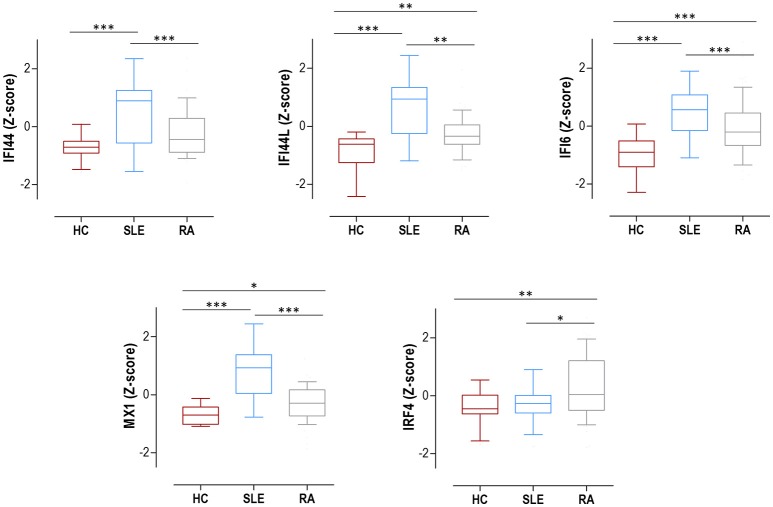
Expression of IRF4 and IRGs in SLE, RA patients and HC. IRF4 and IRGs (IFI44, IFI44L, IFI6, and MX1) gene expression in HC (dark red boxes) (n = 28), SLE patients (blue boxes) (n = 75), and RA patients (gray boxes) (n = 98). Results are shown as box plots, where the boxes represent the 25th and 75th percentiles, the lines within the boxes representing the median, and the lines outside the boxes represent the minimum and maximum values. Differences were assessed by Kruskal-Wallis with Dunn-Bonferroni tests for multiple comparisons. P-values correspond to those obtained in the multiple comparisons tests and are indicated as follows: *p < 0.050, **p < 0.010, and ***p < 0.001.